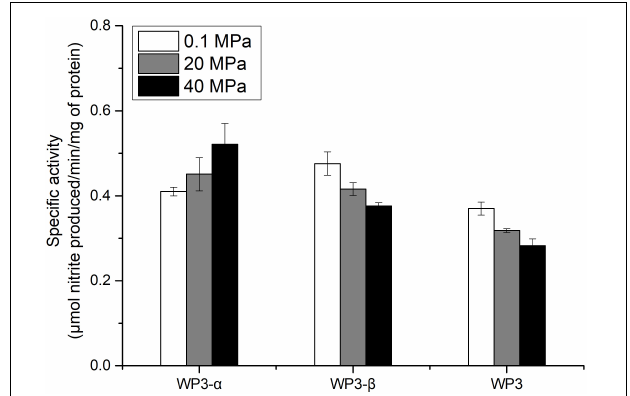
FIGURE 3 | Effect of pressure on the nitrate reductase activity in the periplasmic fractions of WP3 and two napA mutants. WP3 and the mutants were cultured at different pressures with the supplementation of substrate. Cells from the mid-exponential phase were harvested, and the periplasmic fractions were obtained. The specific activity of nitrate reductase was measured. Each value is the average of three measurements.